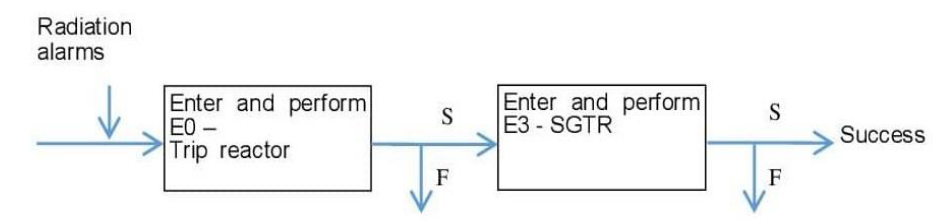
Figure 5. Task diagram in HRA (U.S.NRC,